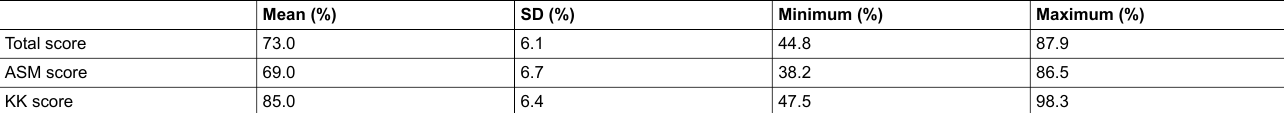
Table 2: Mean, standard deviation (SD), minimum and maximum as percentage of the total examination score ‒ anamnesis status management (ASM) and communication competencies (KK) component